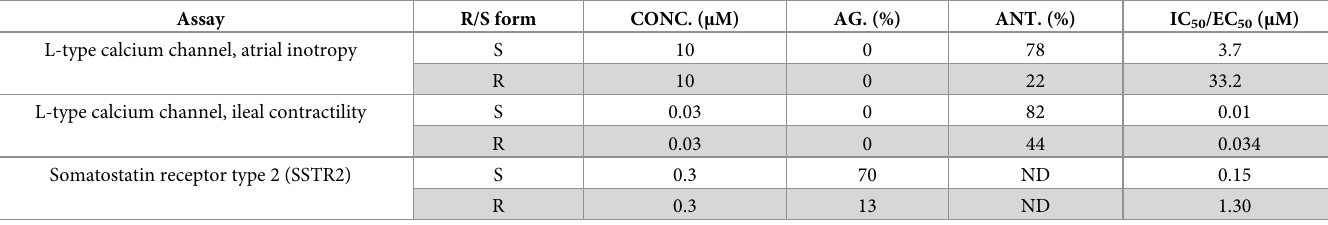
Table 5. Tissue assay of R-Vera and S-Vera on L-type calcium channel and SSTR2. Agonistic and antagonistic activities were measured by isometric (atrial inotropy and SSTR2) and isotonic (ileal contractility) methods. Assay